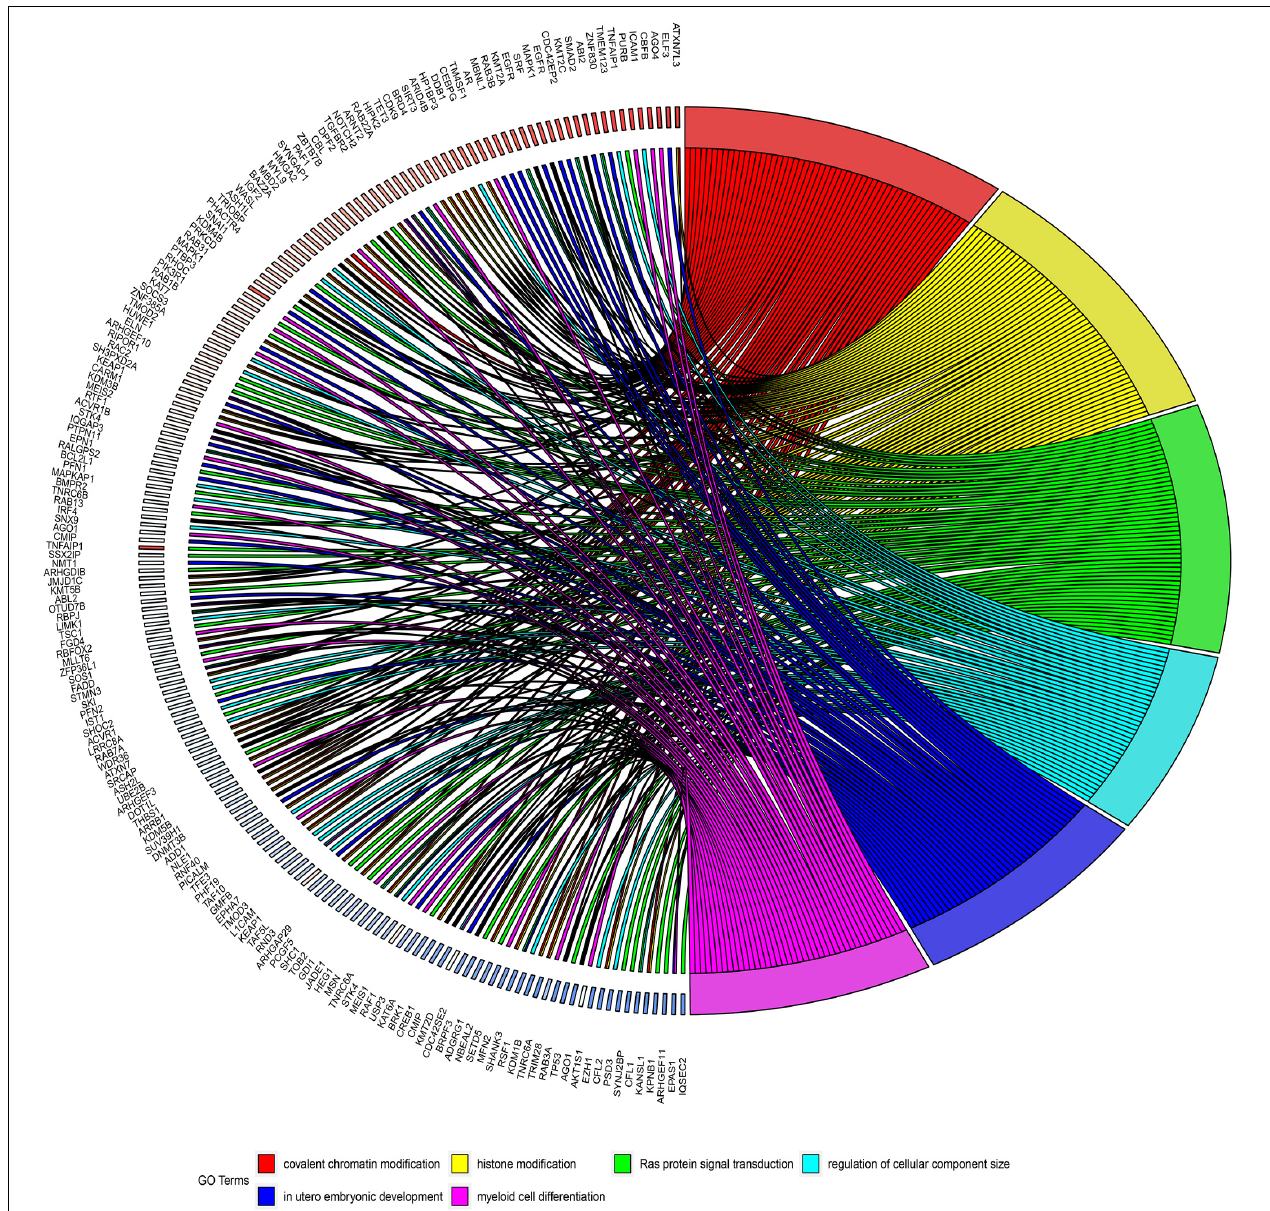
FIGURE 7 | Circos diagrams illustrating six biological processes in which target genes are involved. The right half of the figure shows six biological processes in which the target genes may be involved, including myeloid cell differentiation, and the left half of the figure shows the target genes involved in the six biological